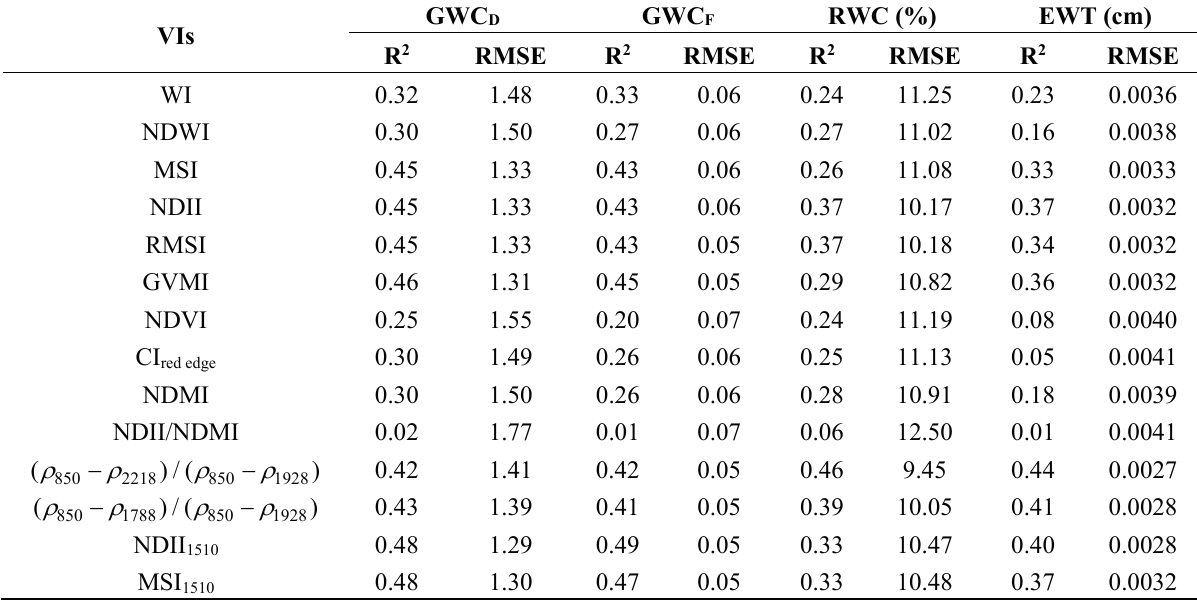
Table 5. Statistics of the relationships between Vegetation Indexes (VIs) and gravimetric water content (GWC), relative water content (RWC), and equivalent water thickness (EWT) at leaf level of winter wheat. Given the number of samples (140 samples), the significant relationship ( p < 0.001) was indicated by R 2 greater than 0.2. GWC D GWC